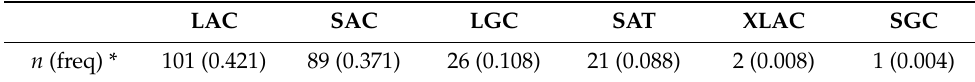
Table 2. SLC6A4 promoter haplotypes detected by SMRT sequencing. LAC SAC LGC SAT XLAC SGC n (freq) * 101 (0.421) 89